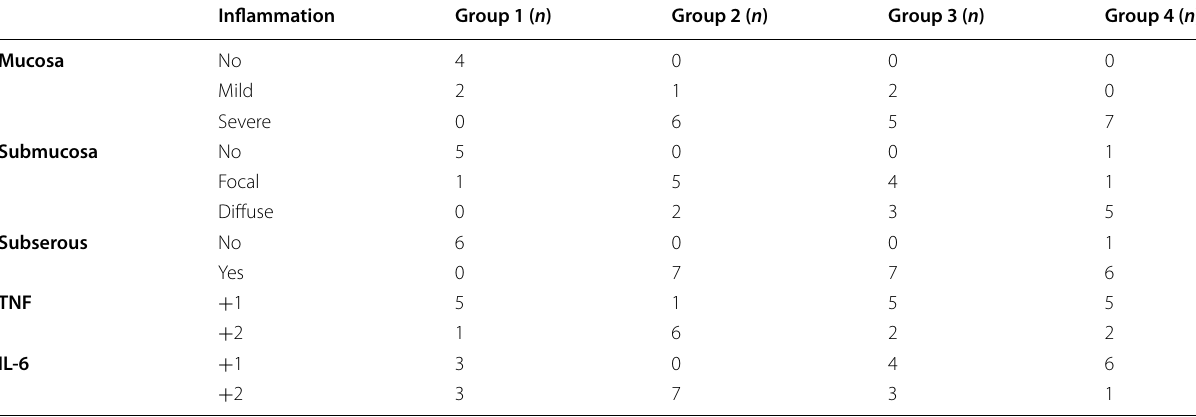
Table 2 Immunohistochemical results of all